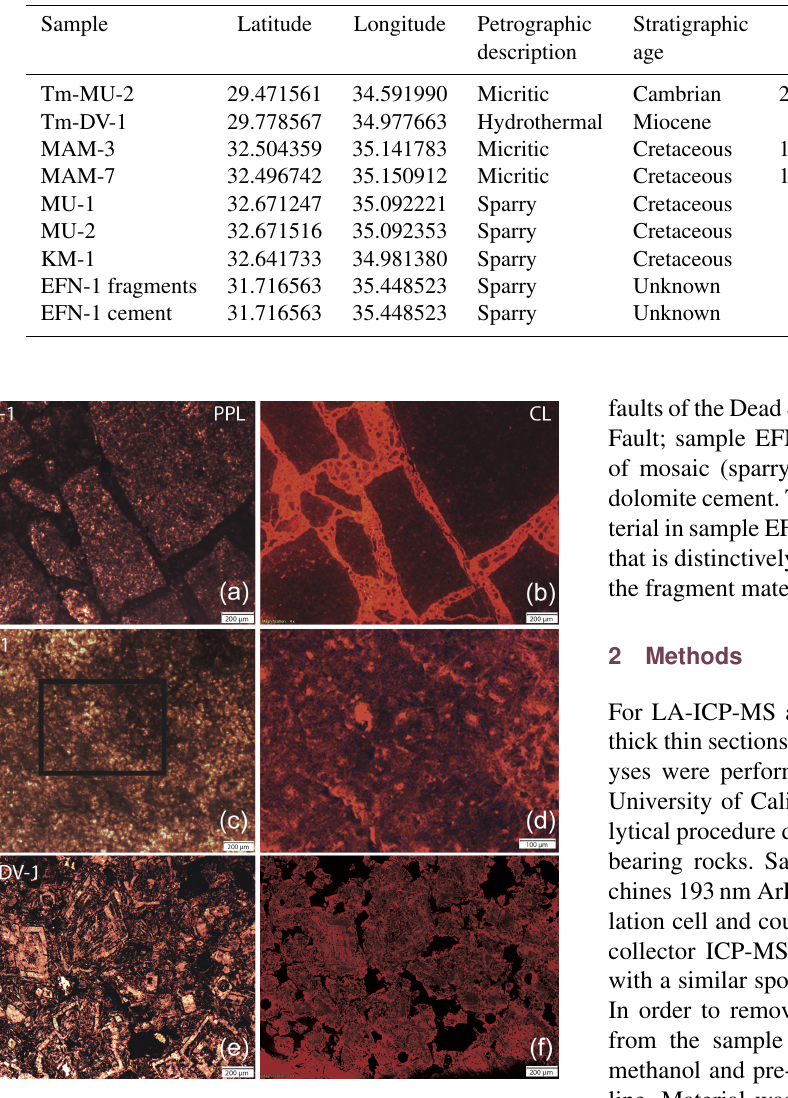
Figure 2. Plane-polarized light (PPL) images (a, c, e) and cathodo- luminescence (CL) images (b, d, f) of representative studied sam- ples. Note the differences in CL colors of breccia fragments and ce- ment in sample EFN-1, the non-homogenized CL response in sam- ple KM-1, and the zoned dolomite crystals in sample